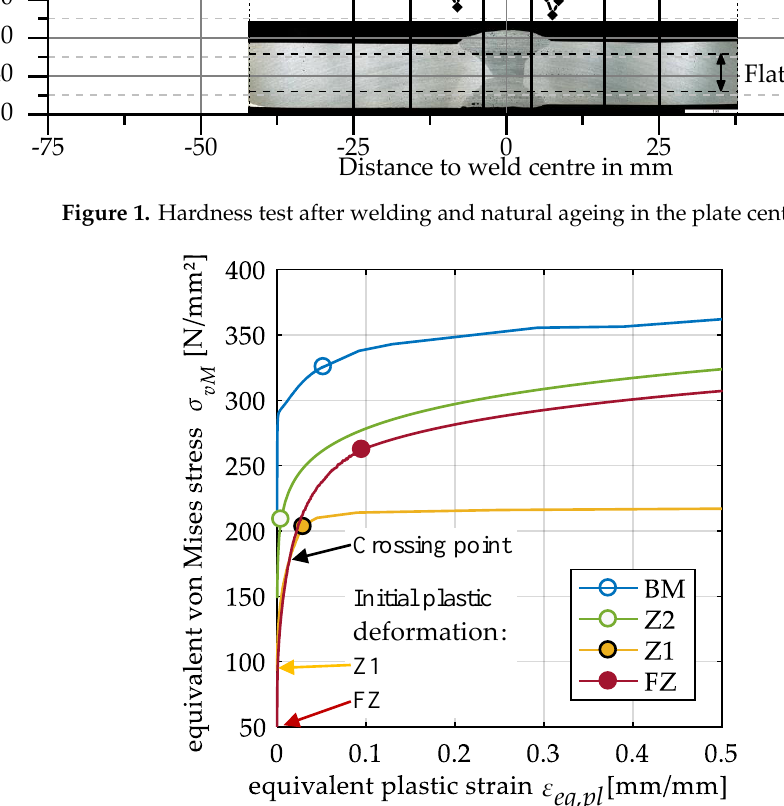
Figure 2. Flow curves of base material (BM), fusion zone (FZ), and heat-affected zone (HAZ) (zone 1 (Z1) and zone 2 (Z2)). The circles mark the last data point directly calculated from measured force – displacement curves (data from [16]).